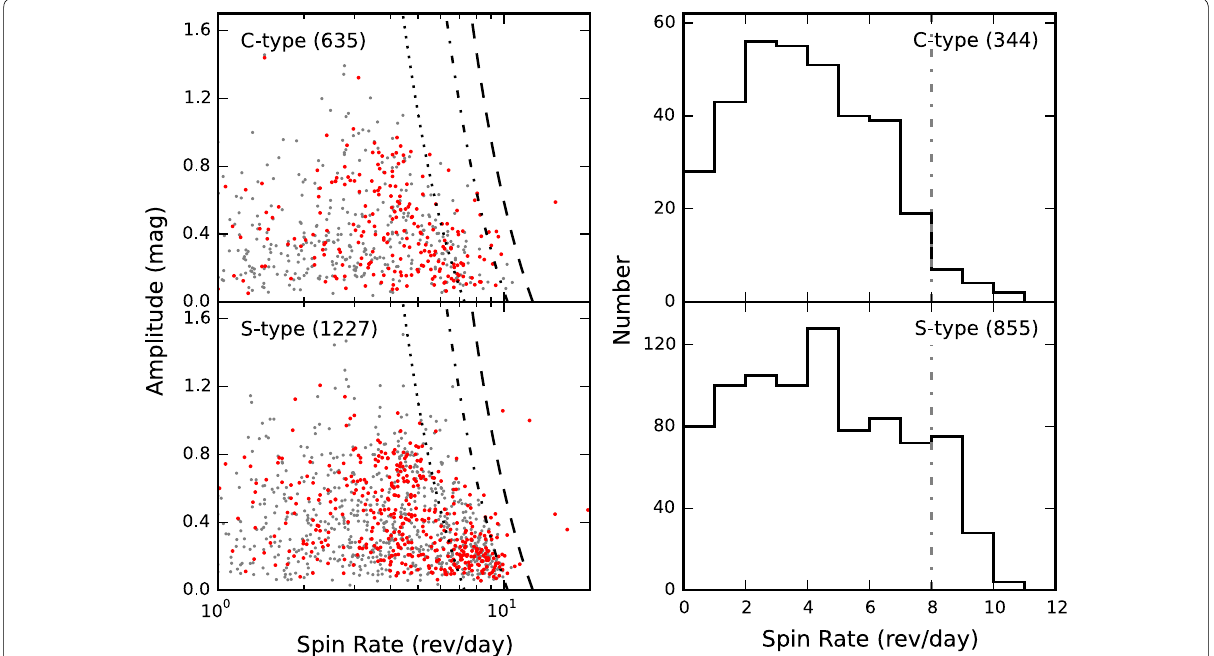
Fig. 5 Light‑curve amplitude vs. spin rate ( left ) and spin‑rate distribution ( right ) for the C‑ ( upper ) and the S‑type ( lower ) asteroids. The gray and red filled circles are objects of the LCDB and the PTF‑U2s, respectively. The number of asteroids used in the statistics is given in each plot. The spin‑rate � m )/ρ (Pravec and Harris 2000), are represented by dashed , dot-dashed , and dotted lines for rubble‑pile asteroids with bulk 3.3 √ ( 1 limits, P ∼ + densities of ρ 3, 2, and 1gcm − 3 , respectively. The spin‑rate distributions use only asteroids of 3 < D < 20 km. This figure is reproduced from = Chang et al. (2015,